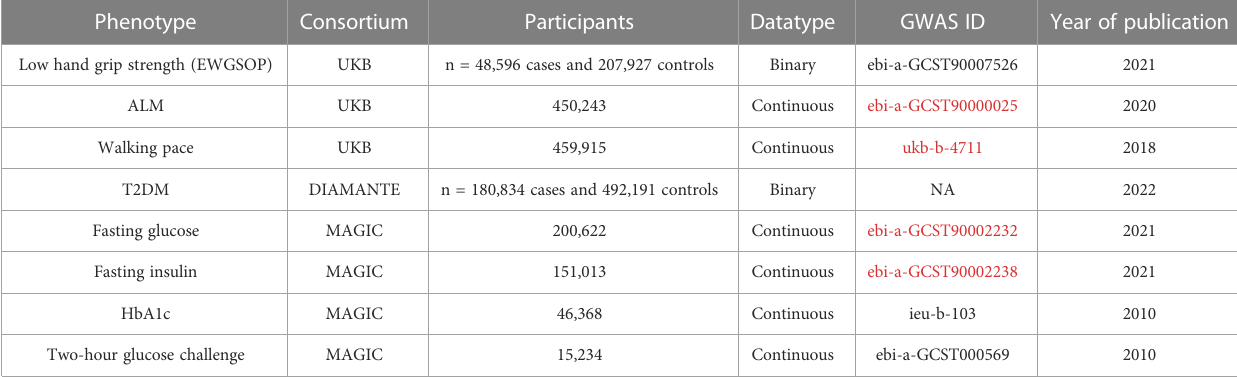
TABLE 1 Phenotype source and